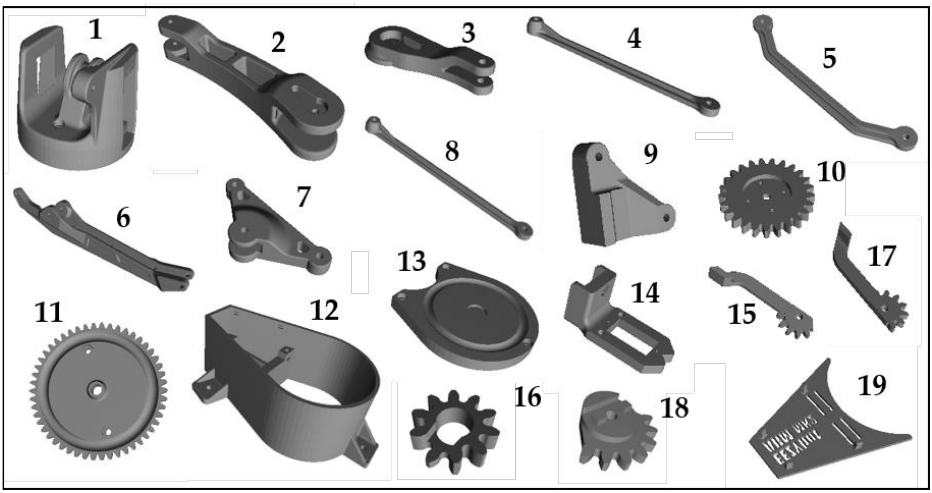
Figure 5. Group of parts considered for production planning. The numbers 1 to 19 represent the part IDs Table 1. Sample data related to the parts used for the case study.